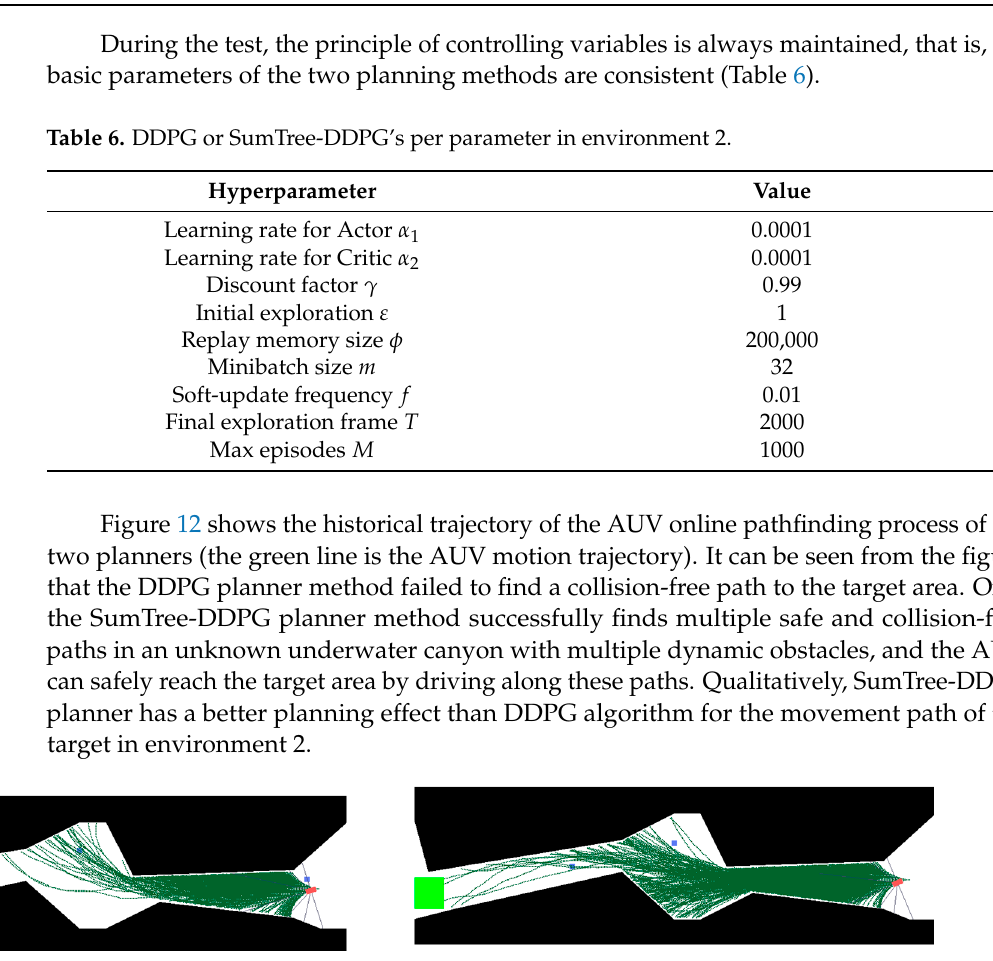
Table 6. DDPG or SumTree ‐ DDPG’s per parameter in environment 2.